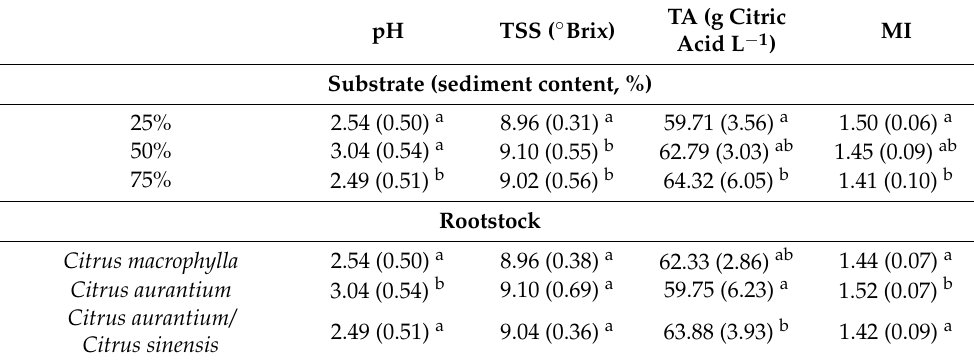
Table 5. Variation of pH, soluble solids (TSS, ◦ Brix), titratable acidity (TA, g citric acid L − 1 ), and maturity index (MI) parameters of ‘Verna’ lemons obtained on different rootstocks and substrates. The values represented are the mean with its standard deviation in